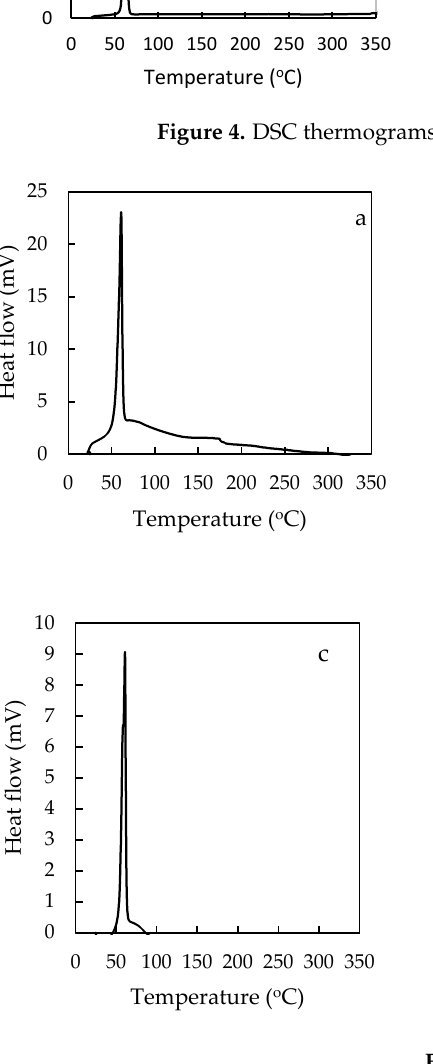
Table 1. Thermal properties of MOLP and solid dispersions at the heating rate of 10 °C min − 1 .